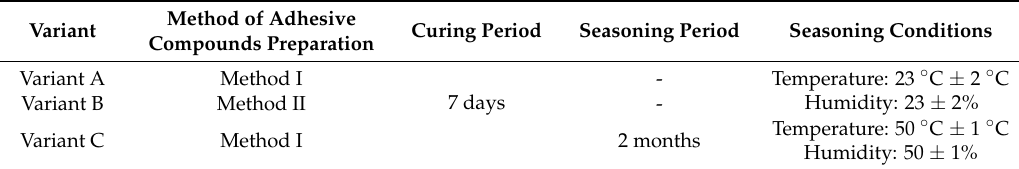
Table 4. Conditions of hot-dip galvanized steel sheet adhesive joints preparation for the shear strength